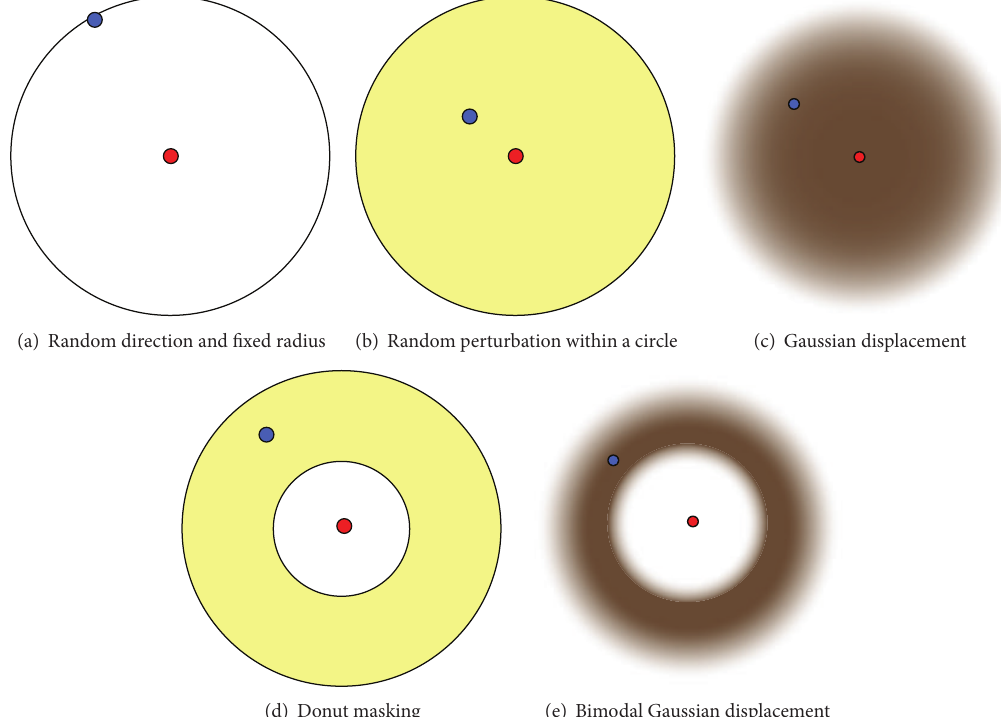
Figure 5: Graphical representation of common geographic masking techniques. The red dot indicates the original location and the blue dot one of the many possible masked